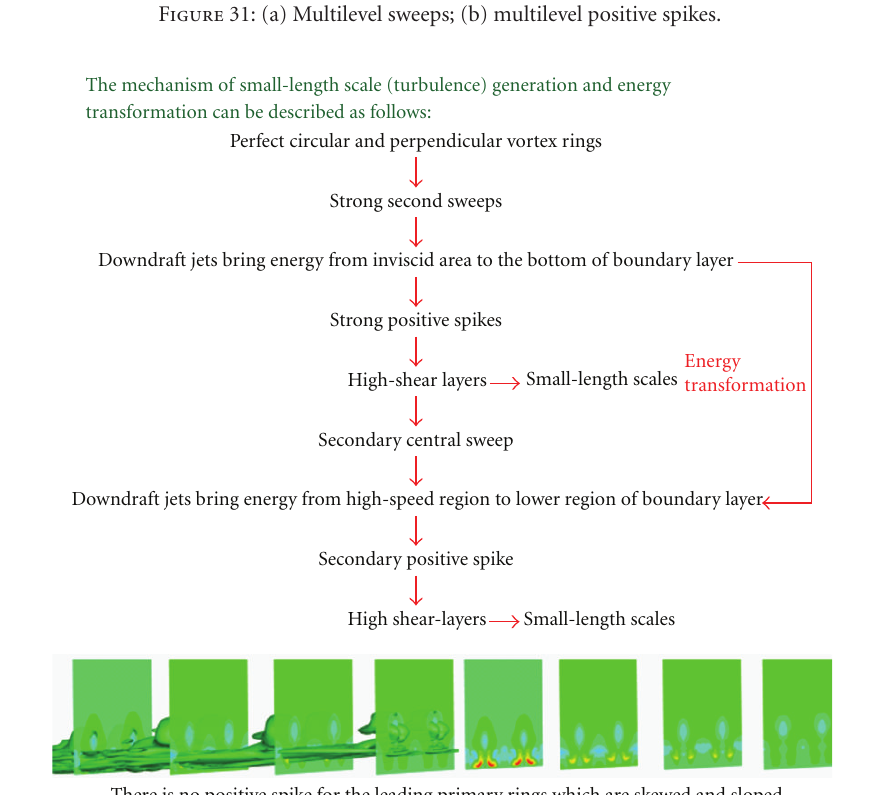
Figure 31: (a) Multilevel sweeps; (b) multilevel positive spikes.